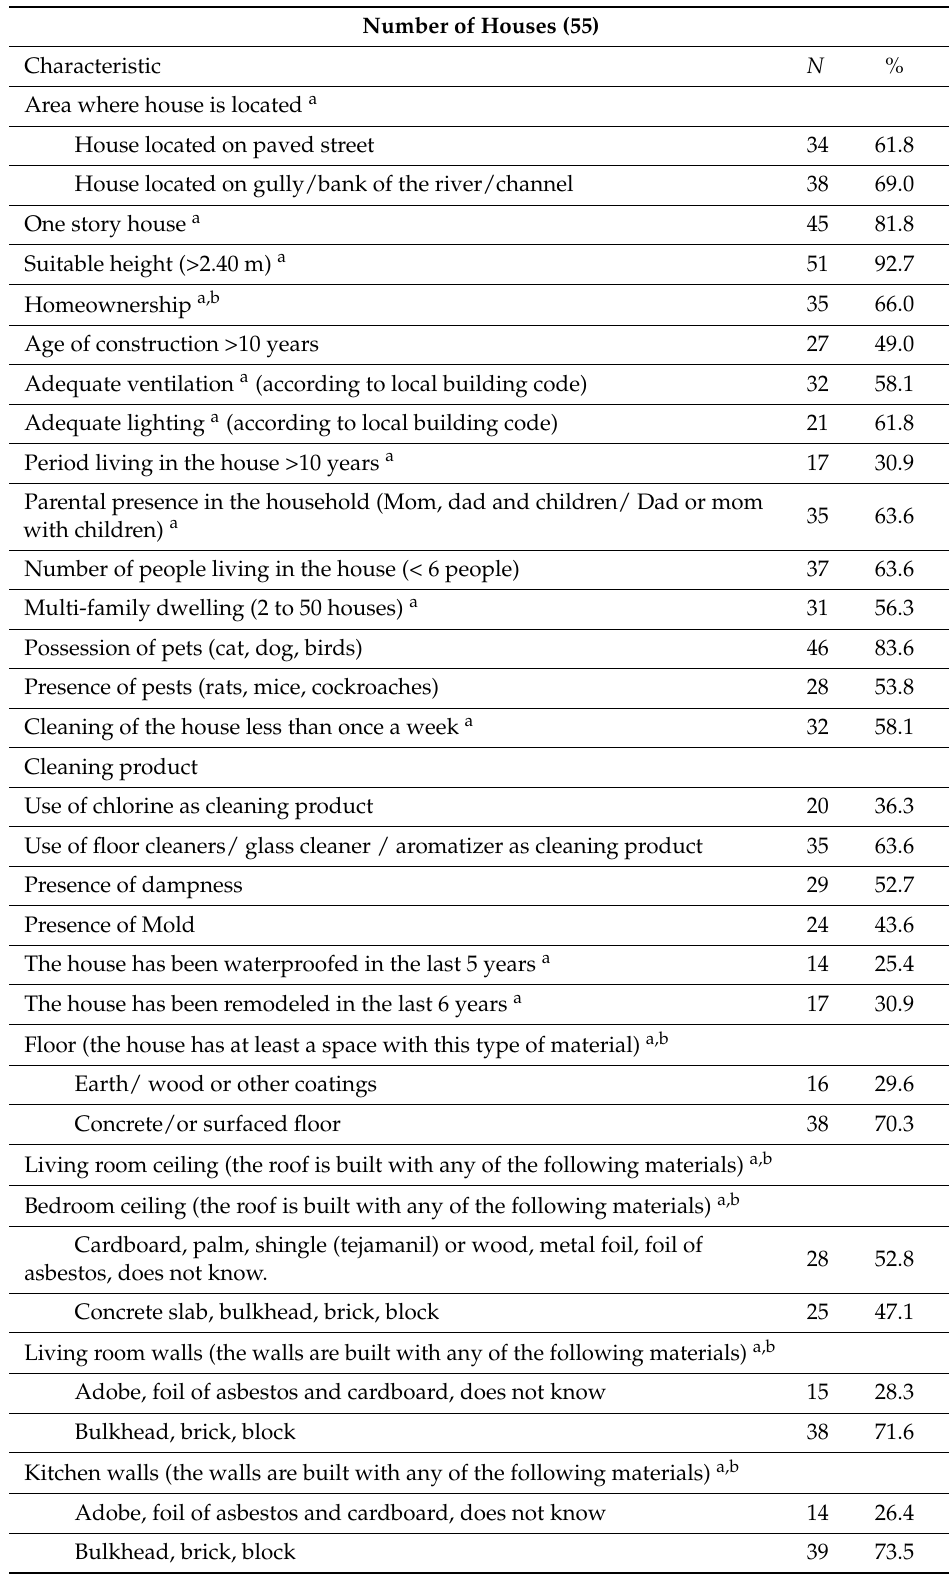
Table 1. Description of the characteristics of the selected houses in Alpuyeca, Morelos. Number of Houses